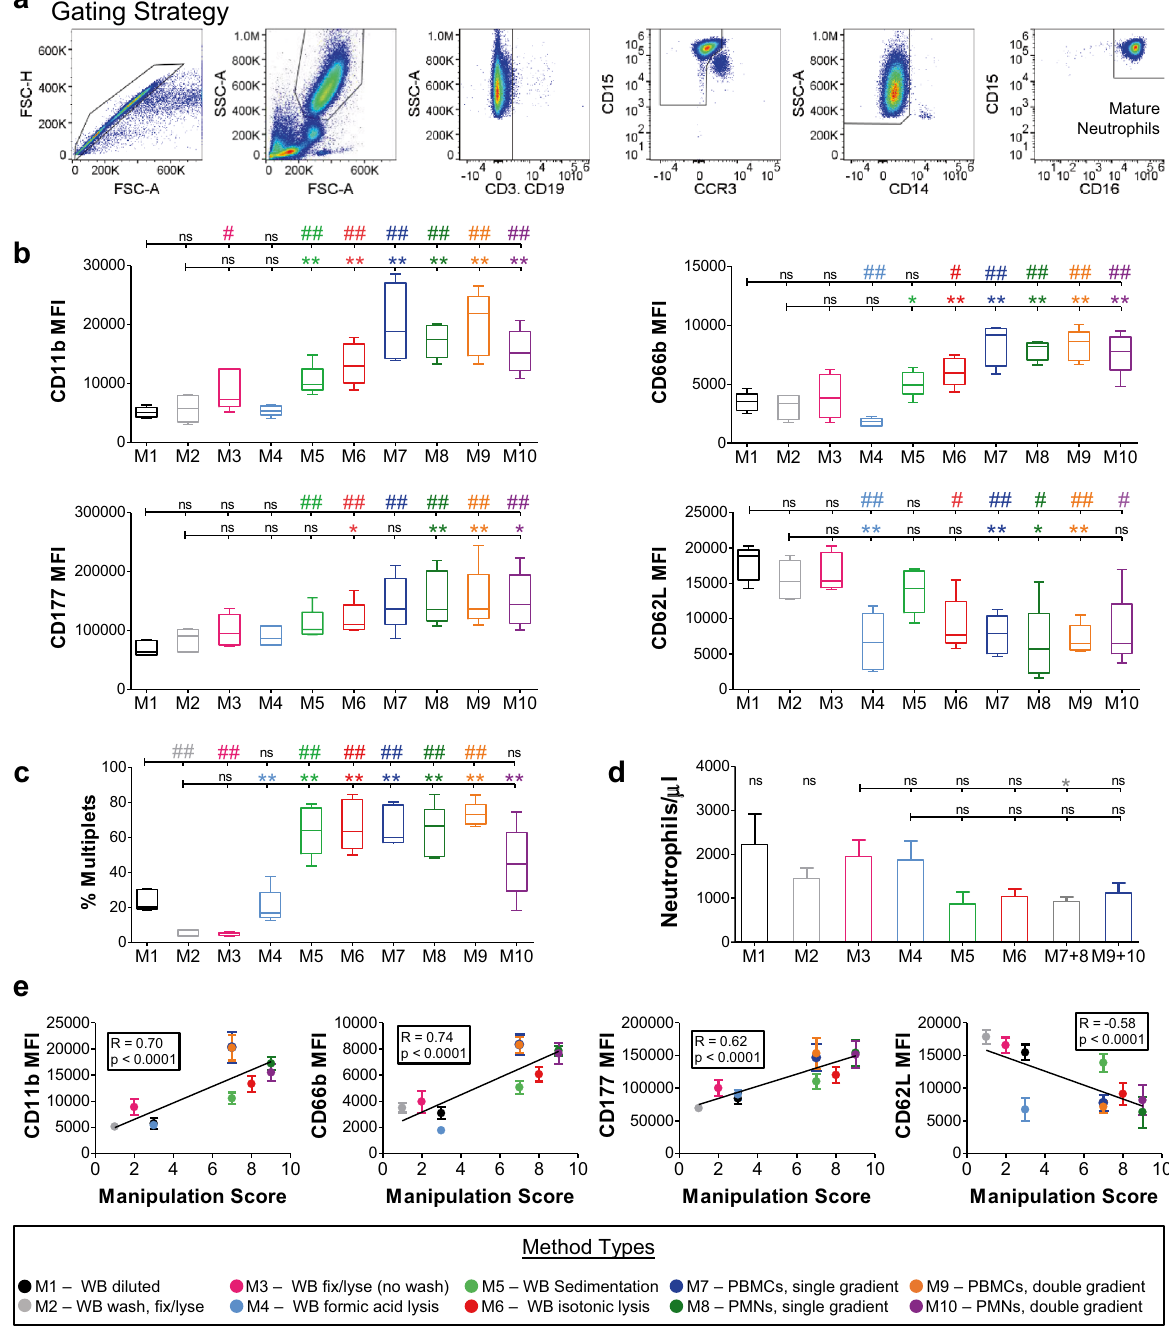
Figure 2. Comparison of methods for neutrophil characterization. ( a ) Strategy for identification of mature neutrophils gated as single cells, SSC and FSC high, and positive for neutrophil markers CD15 and CD16. Negative gates for lineage exclusion were used to identify multiplets with T cells (CD3), B cells (CD19), eosinophils (CCR3), and monocytes (CD14). ( b ) Neutrophil surface levels of indicated proteins following characterization by the methods M1–M10 as defined in Fig. 1 and Methods section. MFI, median fluorescence intensity. Box lines indicate 25th, 50th, and 75th percentiles; whiskers indicate minimum and maximum. ( c ) Percentage of neutrophils forming multiplets during processing using the indicated characterization method. ( d ) Neutrophil recovery per microliter of WB following processing by the indicated method. Bars represent means/SEM. ( b – d ) Methods were compared using Mann–Whitney test # p < 0.05, ## p < 0.01 compared to M1 while * p < 0.05, ** p < 0.01 compared to M2, n = 5. ( e ) Linear regression analyses of indicated neutrophil surface marker levels and manipulation scores as calculated in Table 1 for each tested method. Points are plotted as means ± SEM. In all cases blood was collected in ACD tubes and stained at 4